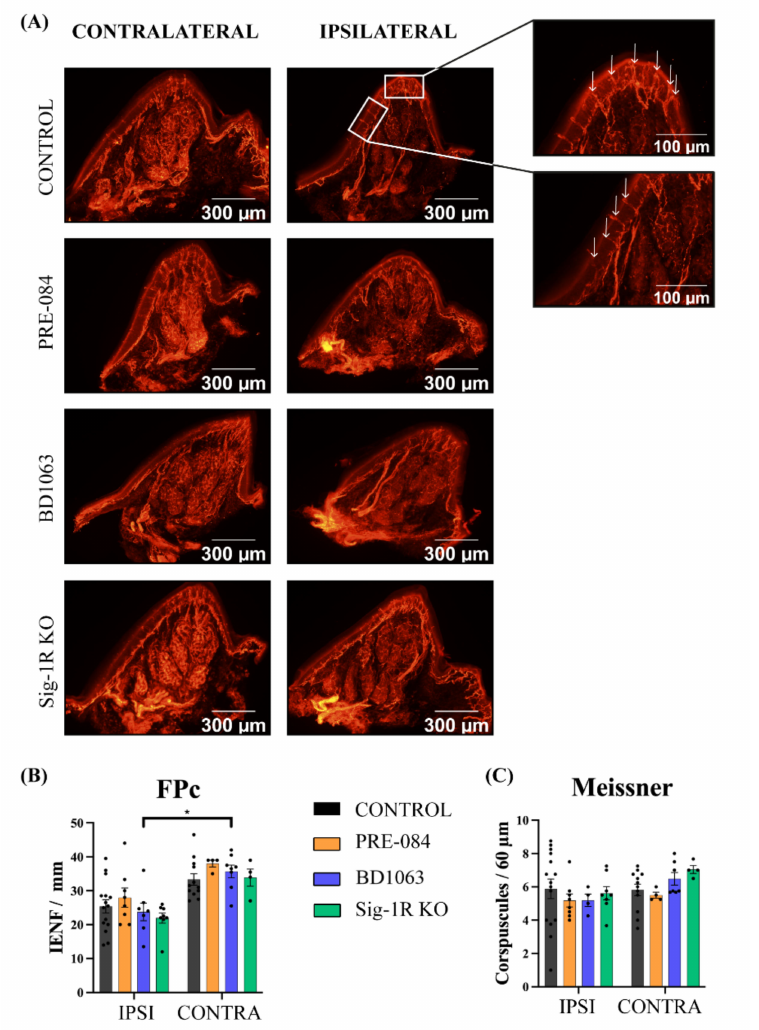
Figure 5. Reinnervation of intra-epidermal nerve fibers (IENF) and Meissner’s corpuscles. ( A ) Representative pictures ( × 10) of the C footpad immunolabeled for PGP9.5 in each group, ipsilat- eral and contralateral to the injury. Inset images showing Meissner’s corpuscles and IENF at the tip and at the side of the pad at higher magnification ( × 40). White arrows point to IENF. Histograms of the density of IENF ( B ) and the number of Meissner’s corpuscles ( C ) for each group in the